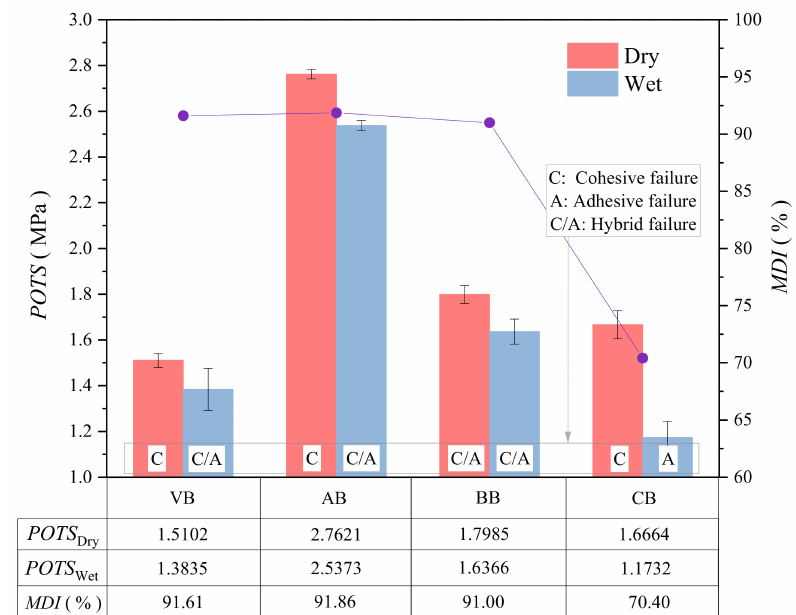
Figure 17. Results for various binder-aggregate systems.